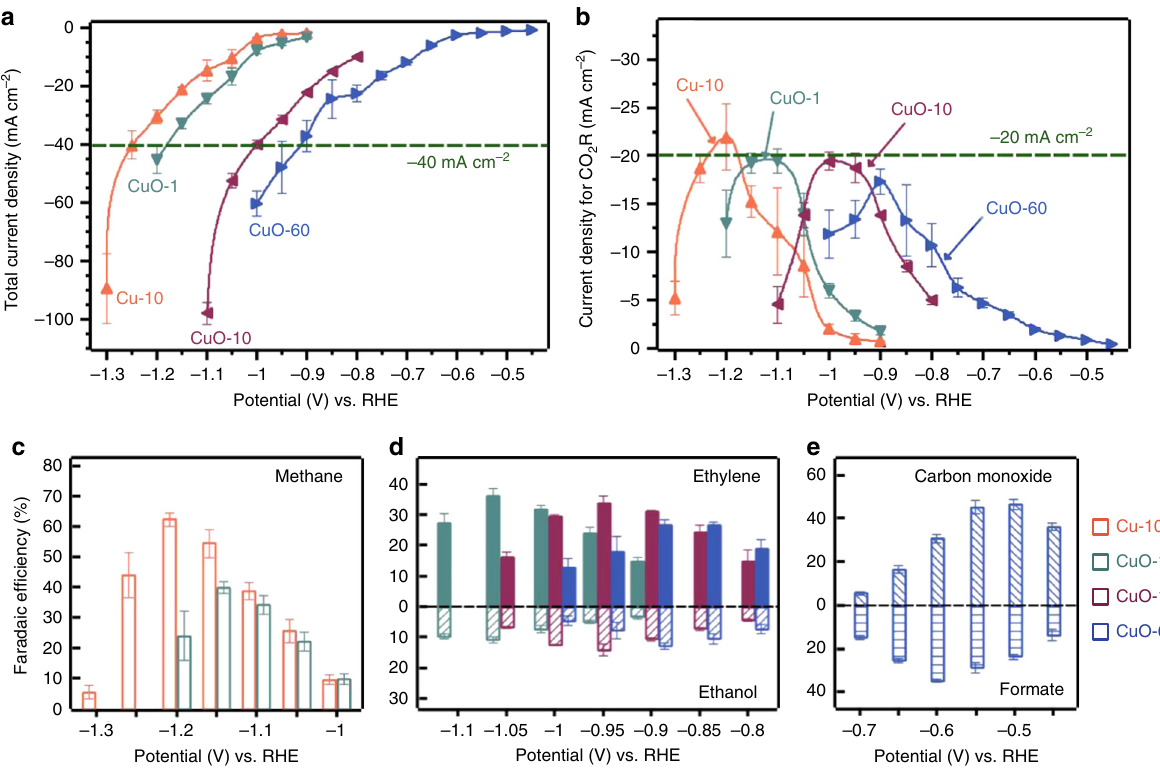
Fig. 2 Electrocatalytic performance of four catalysts toward carbon dioxide electroreduction. a Total geometric current density and b current density for CO 2 reduction (CO 2 R) on four catalysts at different potentials; c faradaic ef fi ciency of methane on Cu-10 and CuO-1 catalysts at different potentials; d faradaic ef fi ciency of ethylene and ethanol on CuO-1, CuO-10, and CuO-60 catalysts at different potentials; e faradaic ef fi ciency of carbon monoxide and formate on CuO-60 catalyst at different potentials. Error bars in a – e represent the standard deviations of three independent